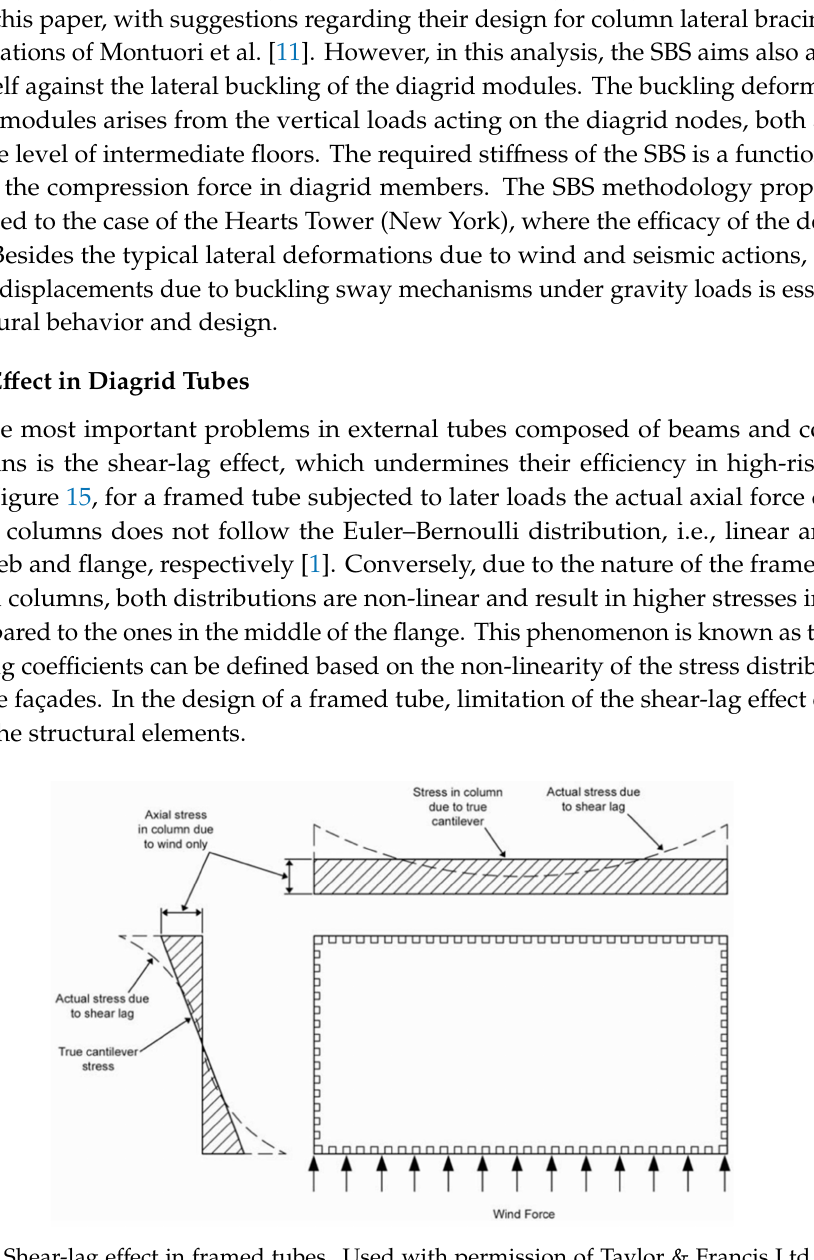
Figure 15. Shear-lag e ff ect in framed tubes. Used with permission of Taylor & Francis Ltd. (www. tandfonline.com), from Ali and Moon